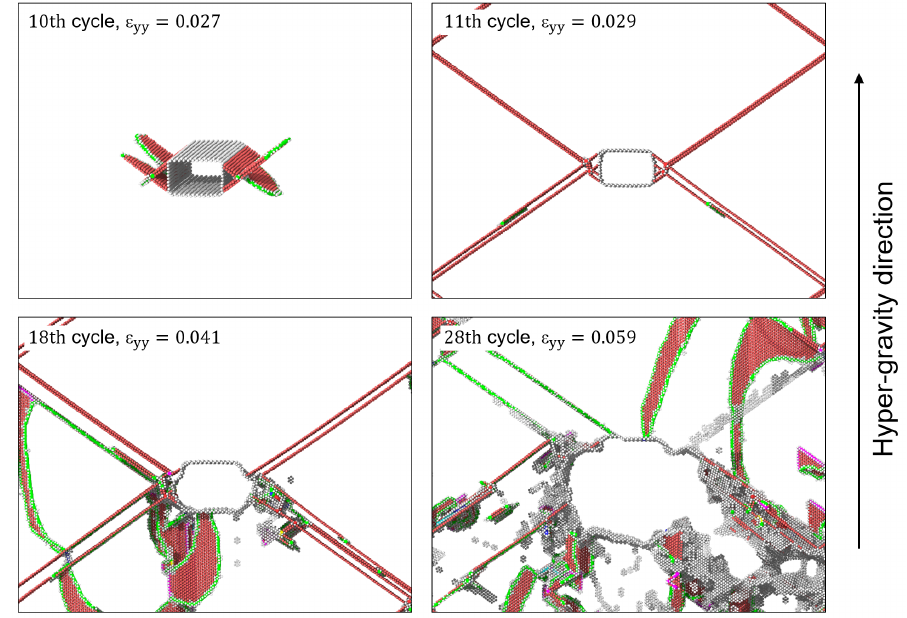
Figure 11. The microstructure evolution of [110]( − 110) crack at 300 K and zero-gravity. For hyper-gravity conditions, the crack is emitted from the left side of the tip in cycle 7, cycle 4, and cycle 1 at 1 × 10 12 g, 3 × 10 12 g, and 6 × 10 12 g, respectively. The stress intensity factor corresponding to zero-gravity, 1 × 10 12 g, 3 × 10 12 g, and 6 × 10 12 g is 0.79 MPa m 1/2 , 0.84 MPa m 1/2 , 0.85 MPa m 1/2 , and 0.86 MPa m 1/2 . The greater the gravity, the greater the crack driving force required for cracks. Figure 12 shows the microstructure diagram of